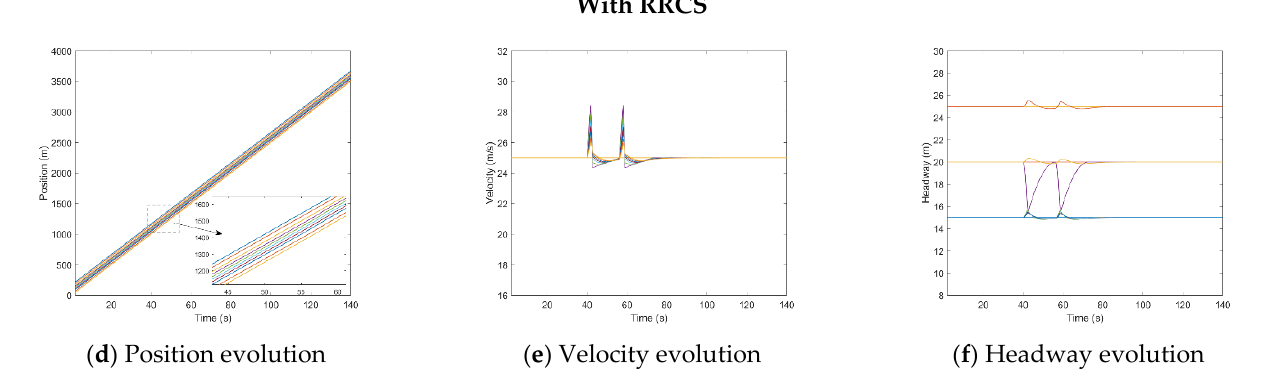
Figure A2. Mixed traffic flow evolution diagrams under the overestimated position with/without RRCS in PATH’s CACC car− following models..